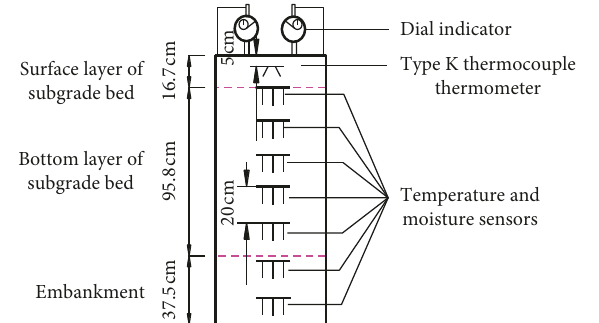
Figure 8: Subgrade model